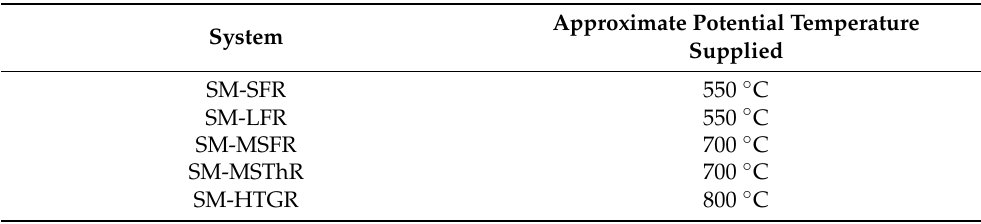
Table 2. Potential temperatures supplied by various systems, in contrast to LWRs which are generally only considered in terms of district heating at ~100 ◦